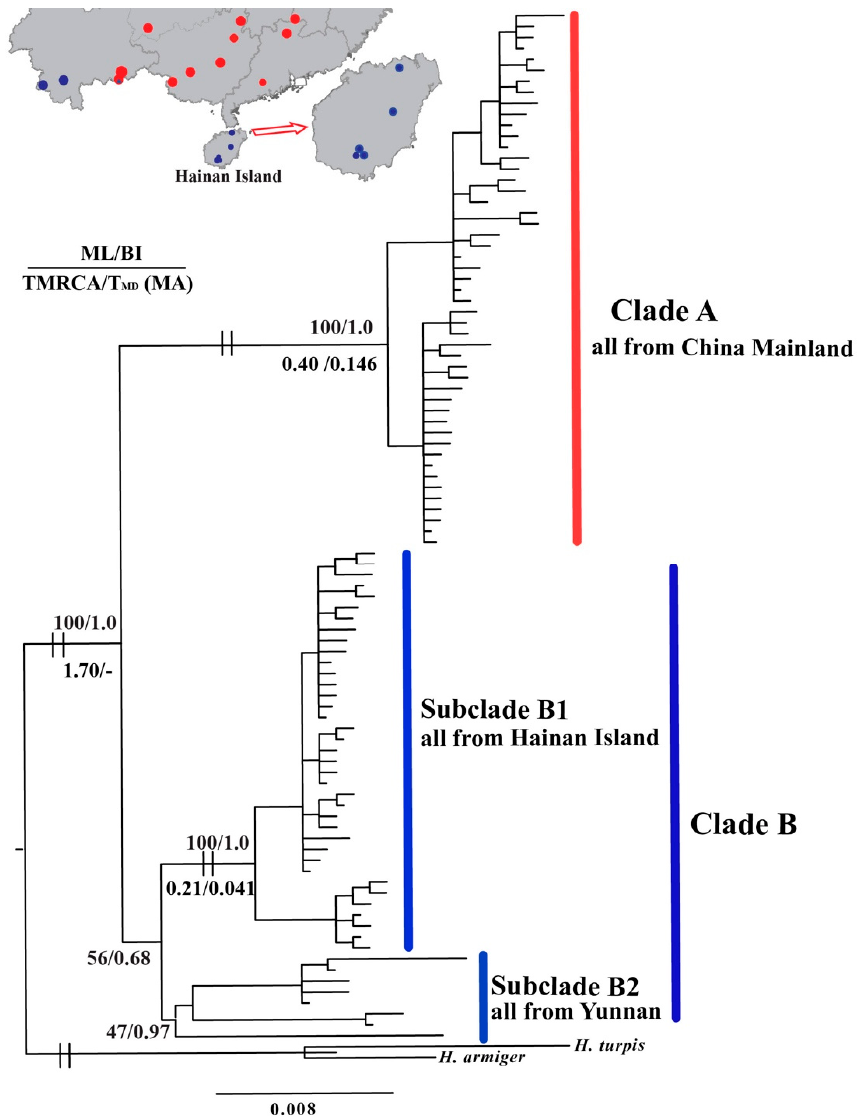
Figure 2. Bayesian phylogenetic tree generated from concatenated mitochondrial cytb and control region sequences of Hipposideros larvatus . Values above branches indicate Bayesian posterior prob- abilities and maximum likelihood bootstrap support values; numbers below branches with high supports are times to the most recent common ancestor estimated using BEAST and estimation of the time of population expansion using mismatch distribution analysis based on a complete cytb gene mutation rate of 0.013 substitutions. The colors are consistent with Figure